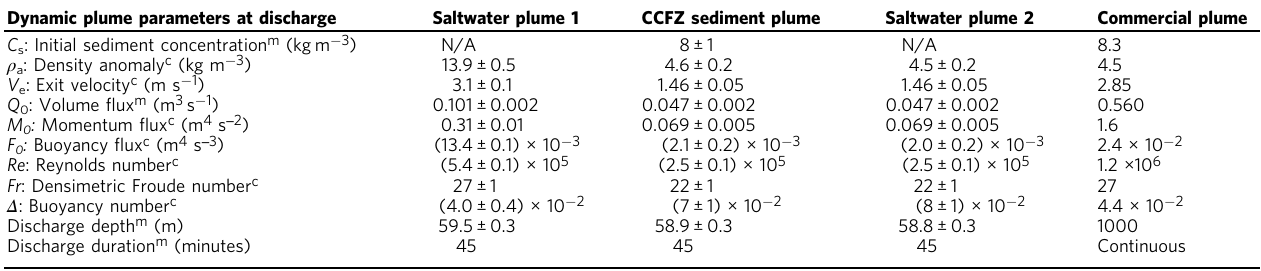
Table 1 Summary of measured ( m ) and calculated ( c ) dynamic plume parameters at the discharge depth.